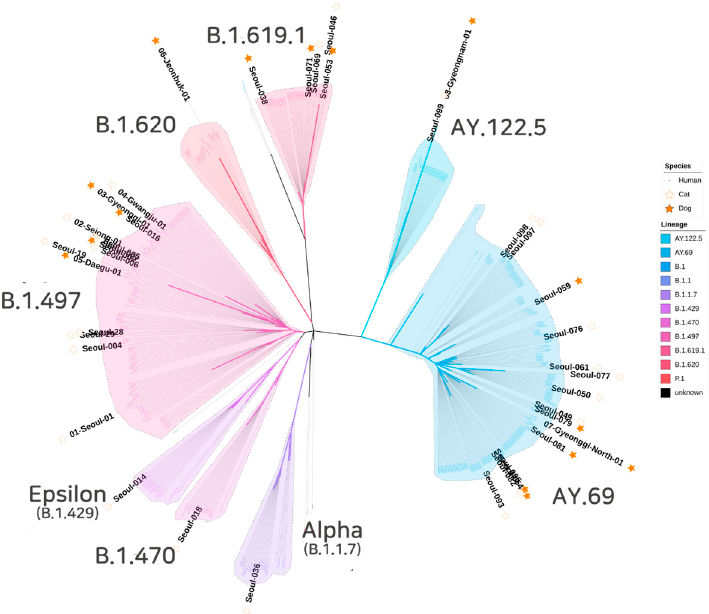
Figure 1. Phylogenetic tree analysis of SARS-CoV-2 whole genome sequences. This tree includes 40 SARS-CoV-2 whole genome sequences obtained in this study (25 dogs and 15 cats) and 421 SARS- CoV-2 complete genome sequences in GISAID from humans in South Korea. The analysis used ML with the GTR and F model.